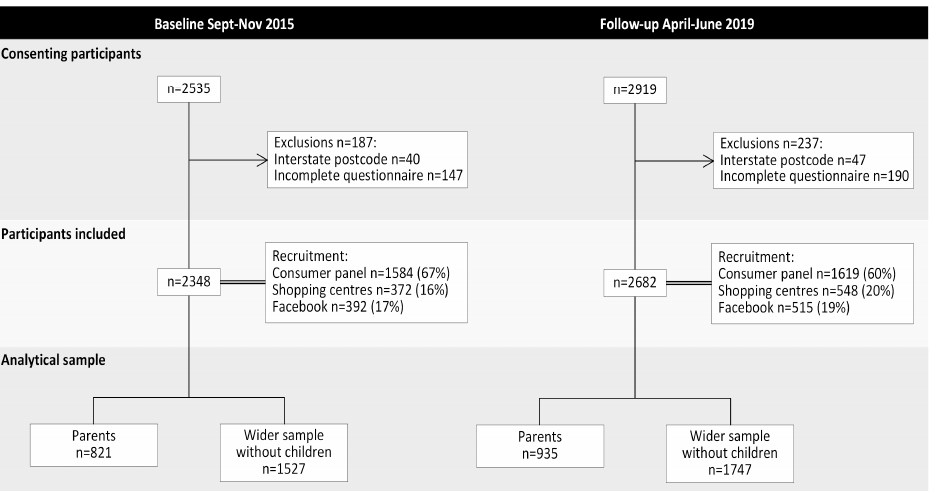
Figure 2. Flowchart of participation at baseline and follow-up.